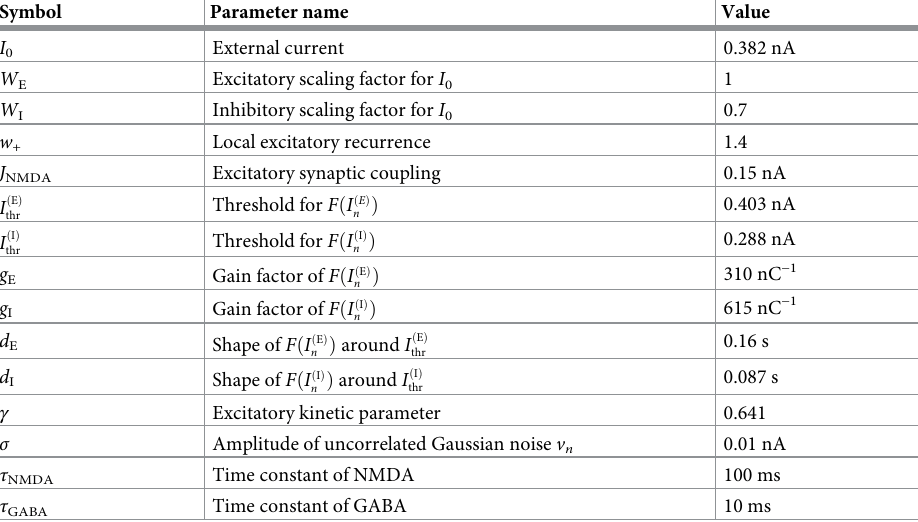
Table 1. Dynamic Mean Field (DMF) model